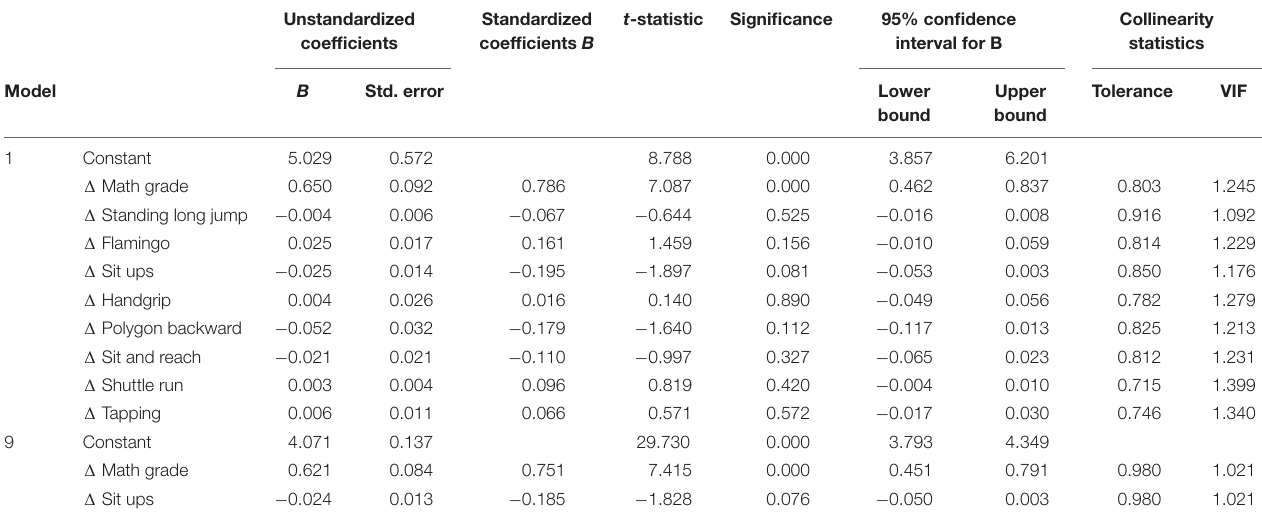
TABLE 6 | Coefficients data for the first and final model with the inclusion of MVPA OB